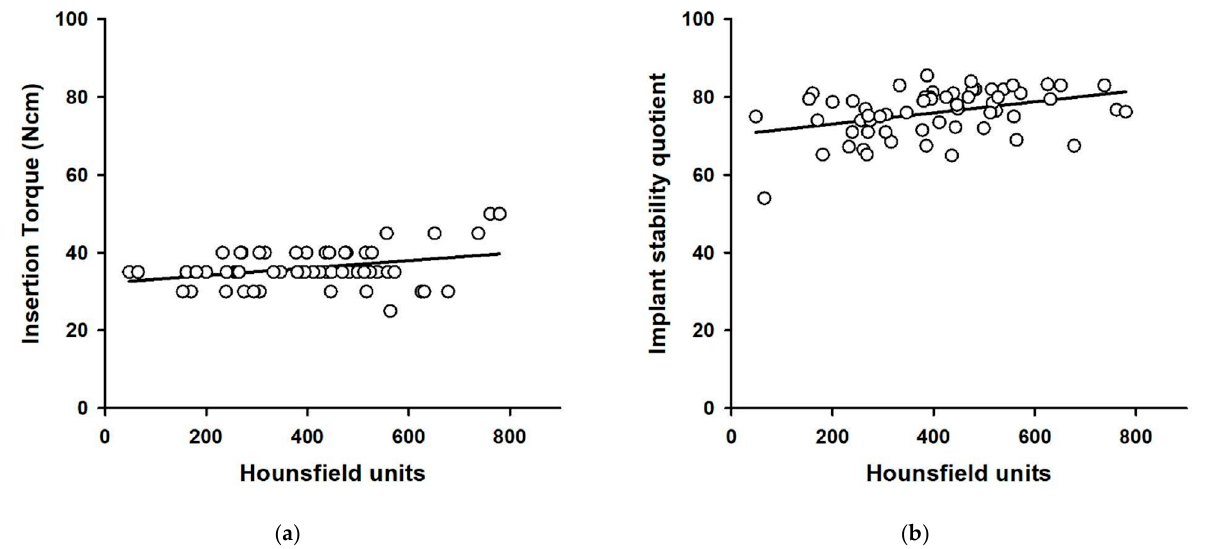
Figure 2. Scatter plots of Hounsfield units vs. insertion torque ( a ) and Hounsfield units vs. implant stability quotient ( b ). Solid lines show the regression line.